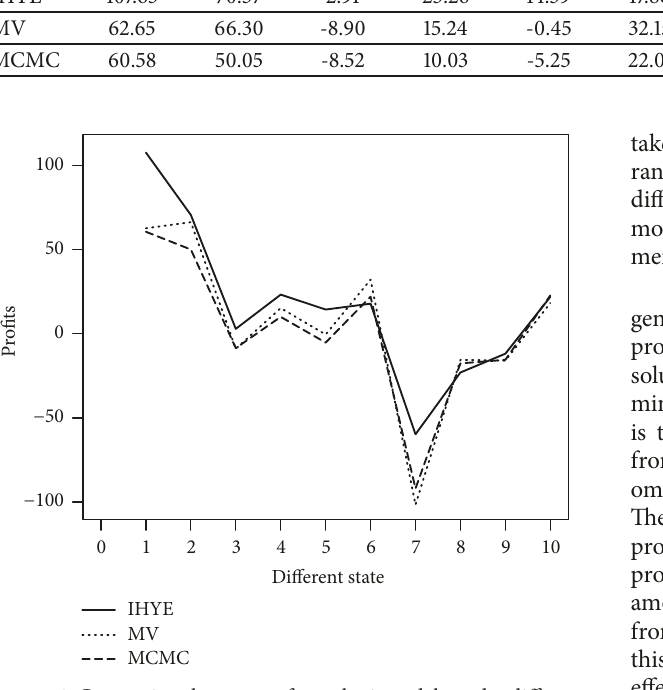
Figure 4: Comparing the returns from the 3 models under different